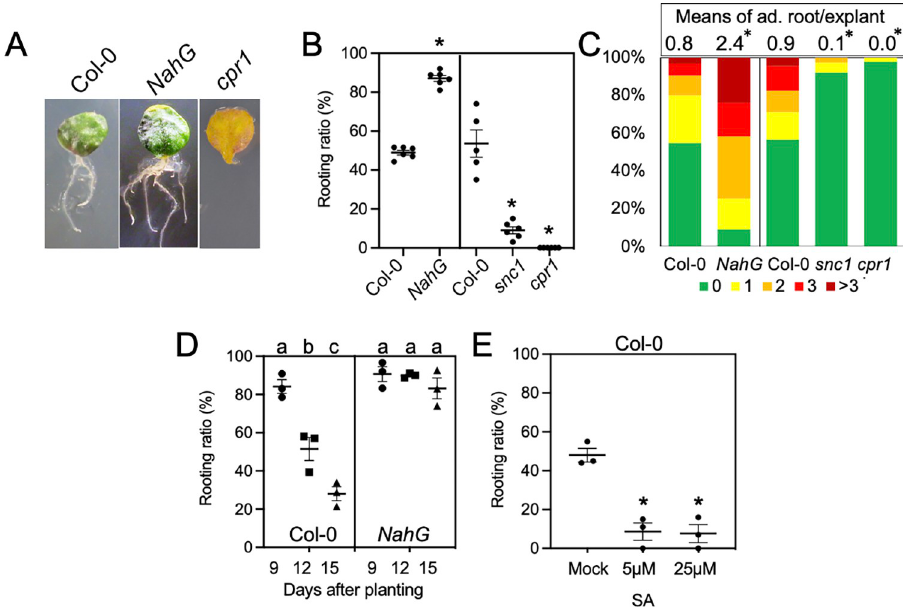
Fig 1. SA repressed the formation of adventitious roots from leaf explants. (A) Representative images of leaf explants at 11 DAC from wild type and mutants. Explants were cut from the first two rosette leaves. (B) The rooting ratio in wild type Col-0 and mutants. � indicates p < 0.01 when compared to Col-0 using student t -test. Long and short bars represent means and standard errors, respectively. (C) The proportion of leaf explants with indicated number of adventitious roots from wild type and mutants. � indicates significant difference using a Mann–Whitney U test when compared to Col-0. (D) The rooting ratio of explants from plants with different age. Different letters indicate significant difference using one way ANOVA. (E) Rooting ratio of Col-0 explants with SA treatment. Each dot in B, D, and E represents an independent experiment with 40–60 explants. Error bars indicate standard error. The rooting data were collected at 11